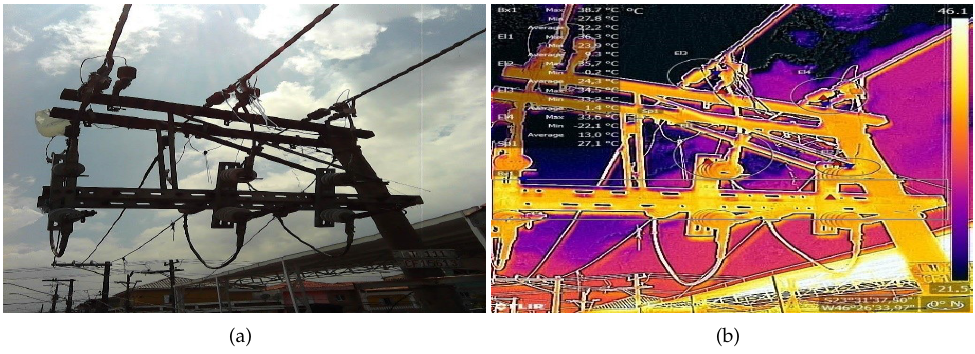
Figure 14. Outputs of using thermal cameras coupled in smartphones. ( a ) original images captured; ( b ) thermal images